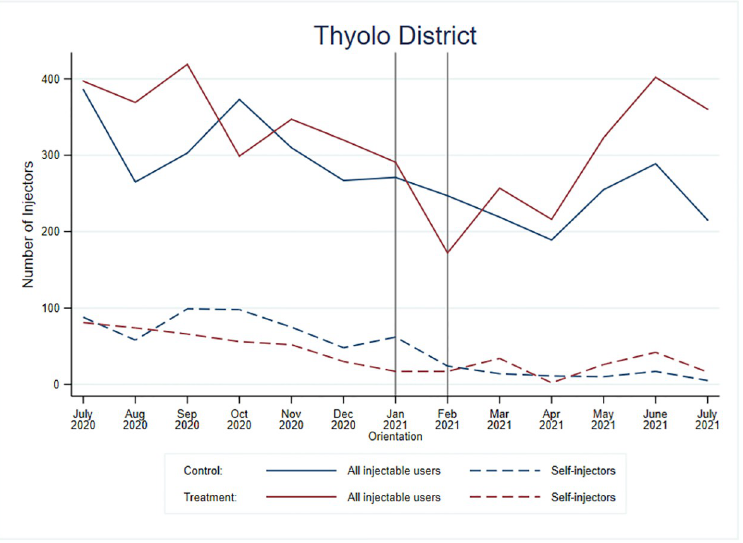
Fig 5. Number of total new injectable users and DMPA-SC self-injectors for treatment and control facilities in Thyolo District, Malawi.